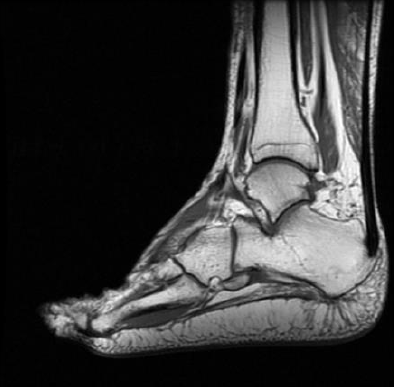
Figure 5. Postoperative MRI shows good tightening of the plantar fascia and the repair of the pre- vious